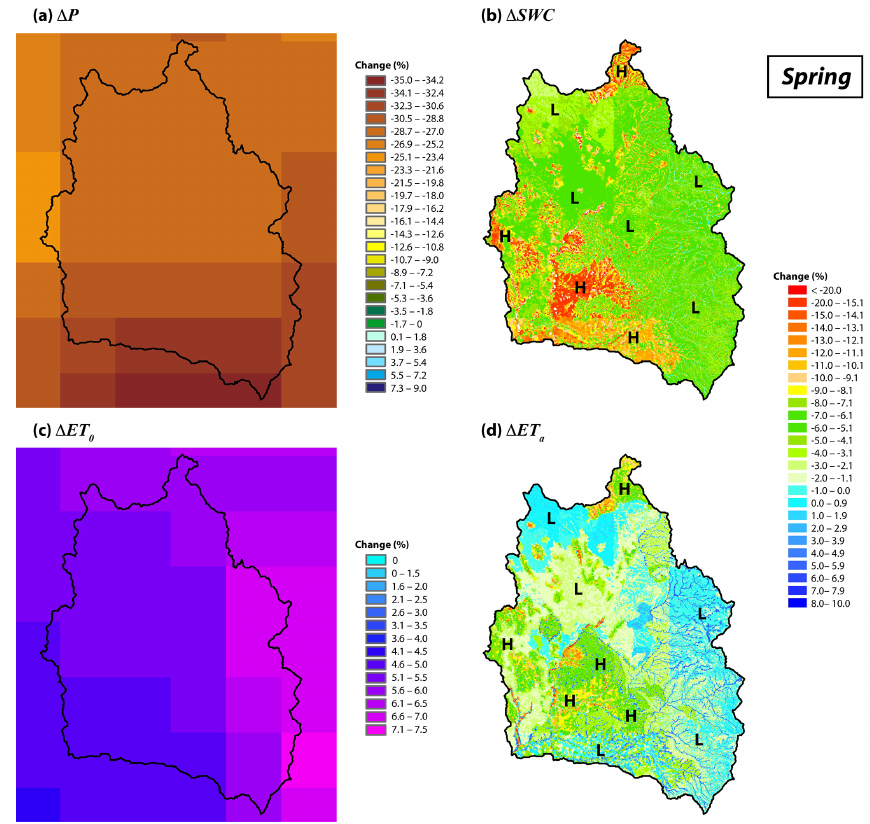
Figure 14. Same as Fig. 13, but for the spring